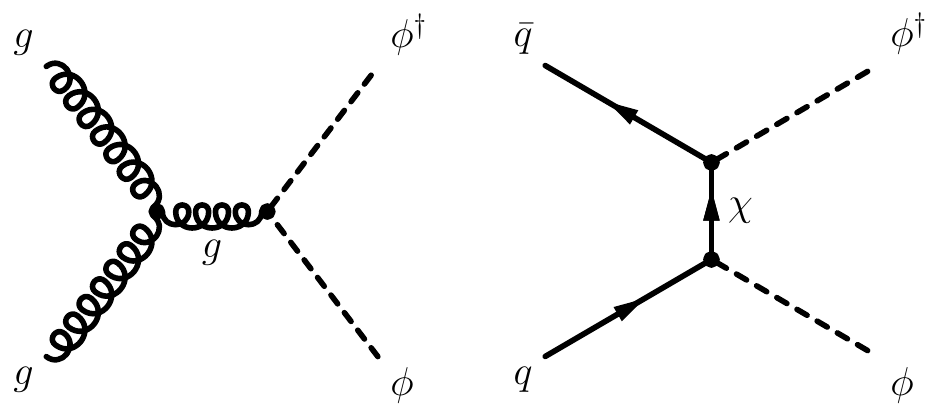
Figure 1 . Representative Feynman diagrams for the production of mediator